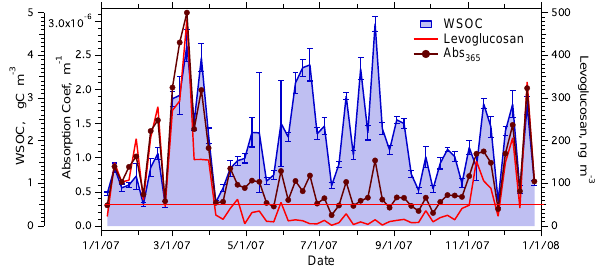
Fig. 5. Median fine particle (PM 2 . 5 ) Water-Soluble Organic Carbon (WSOC), levoglucosan and light absorption coefficient at 365nm (Abs 365 ) averaged over all 15 FRM sites shown in Fig. 1. WSOC error bars are the WSOC standard error. The cutoff of 50ngm − 3 for a biomass-burning influence is shown as a horizontal line.